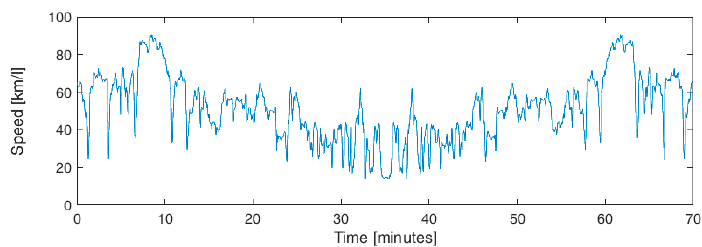
Figure 15. Mountain mission 2 speed profile.